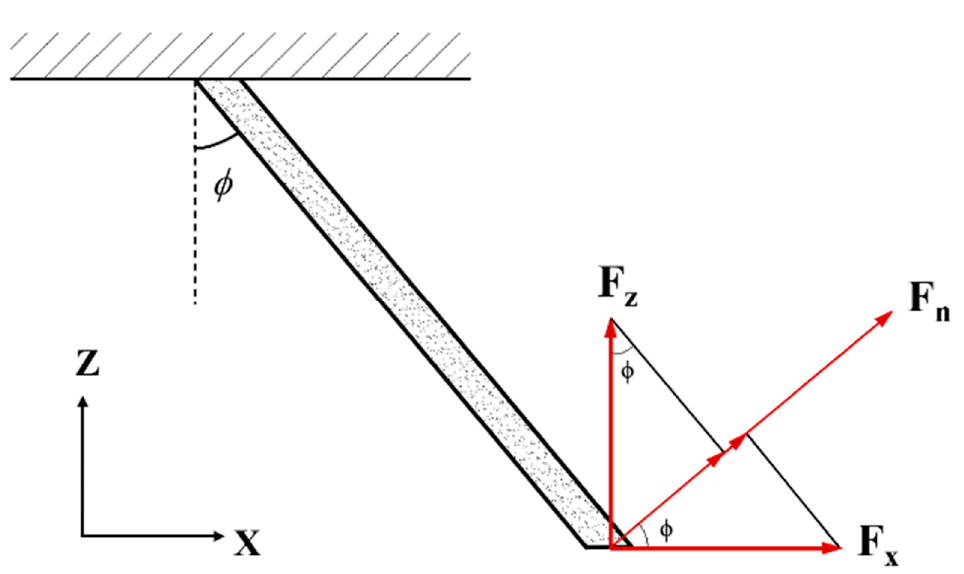
Figure 9. Diagram for normal aerodynamic force on bristles.